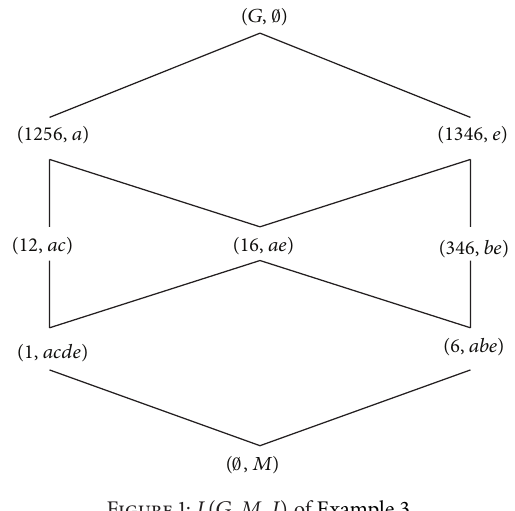
Figure 1: 𝐿(𝐺, 𝑀,𝐼) of Example 3.